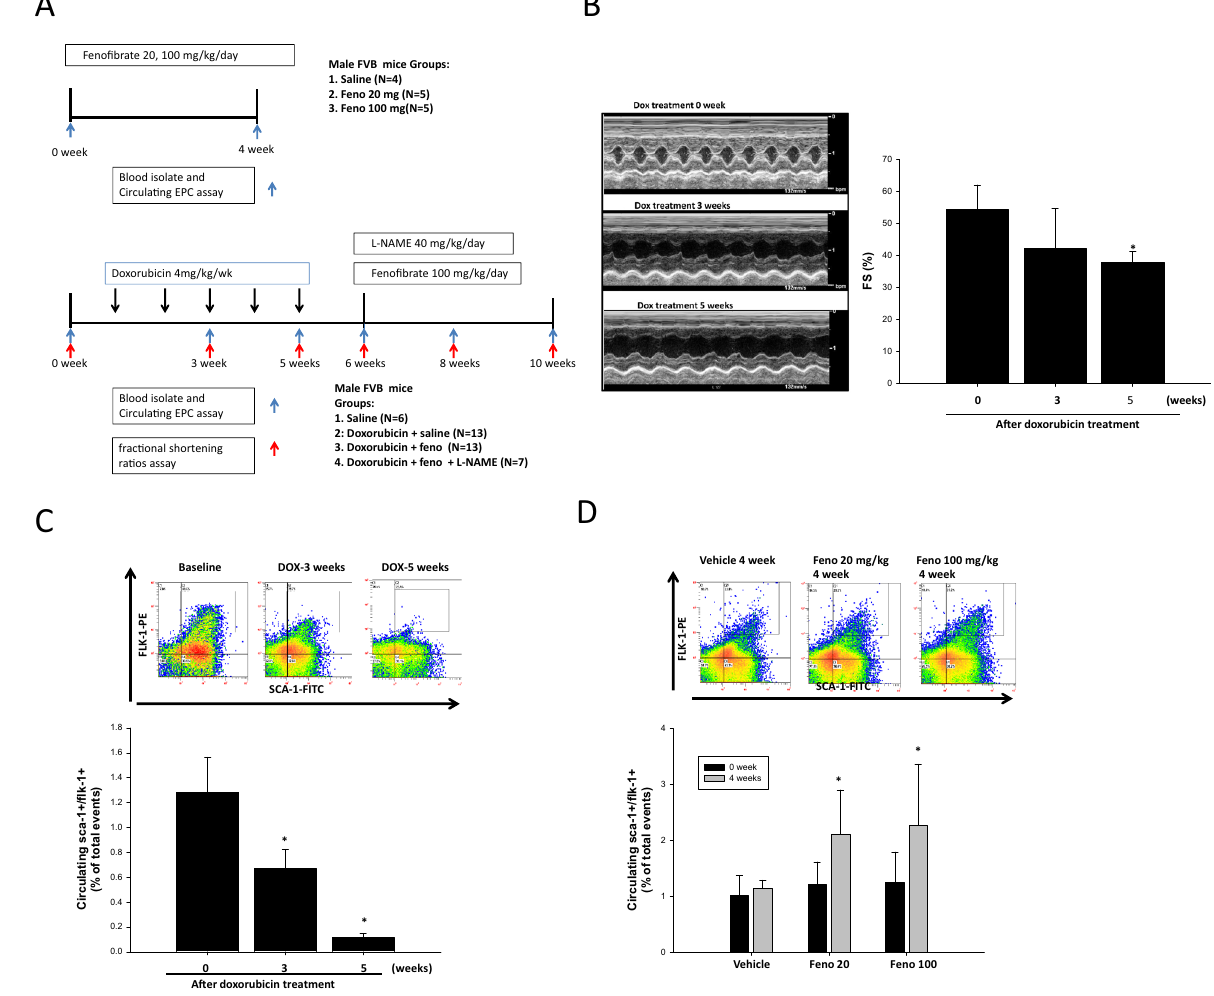
Figure 1. DOX-induced cardiac dysfunction and decrease in the number of circulating EPCs in FBV mice. ( A ) The DOX, fenofibrate, and L-NAME treatment protocols used in this animal study. ( B ) Quantitative analysis of left ventricular short axis fractional shortening (LVFS) after DOX IV injection, which was determined by echocardiography in FBV mice at 0, 3, and 5 weeks. ( C ) The number of circulating EPCs (defined as Sca-1 + / Flk-1 + cells) after DOX IV injection was determined by flow cytometry in FBV mice at 0, 3, and 5 weeks. Doxorubicin n = 33. ( D ) EPC (defined as Sca-1 + /Flk-1 + cells) mobilization after the oral administration of fenofibrate (20 and 100 mg/kg) was determined by flow cytometry in FBV mice at 4 weeks. *p < 0.05 vs. saline. Experiments was with n = 4–5/group. One-way Measurement of cardiac function. Transthoracic echocardiographic analysis was performed as previ- ously described 32 . M-mode images of the left ventricle were recorded after the animals were anesthetized with avertin. The following parameters were measured to evaluate cardiac structure and function: left ventricular end-diastolic diameter (LVIDd), left ventricular ejection fraction (LVEF), and left ventricular short axis frac- tional shortening (LVFS). All parameters were assessed using an average of three heart beats. Determination of plasma biomarker concentrations. Blood samples were collected from the hearts after the animals were euthanized. The levels of MMP2, MMP-9, TNF-α, VEGF, adiponectin, BNP, and NT-pro- BNP in circulation were determined by ELISA kits. Mouse MMP-9, VEGF, and adiponectin ELISA kits were purchased from R&D Systems (Minneapolis, MN), mouse TNF-α ELISA kits were purchased from Invitrogen (Carlsbad, CA), and mouse BNP and NT-pro-BNP ELISA kits were purchased from MyBioSource (San Diego, CA, USA). The procedures were carried out according to the manufacturers’ instructions. Hematoxylin and eosin (HE) staining. The left ventricle (LV) myocardium was fixed in 4% formalin, cut transversely, embedded in paraffin, and stained with hematoxylin and eosin. Five randomly selected fields per section were analyzed. Digital photographs were taken using a high-resolution digital image analysis system (QwinV.3, Leica, Germany).